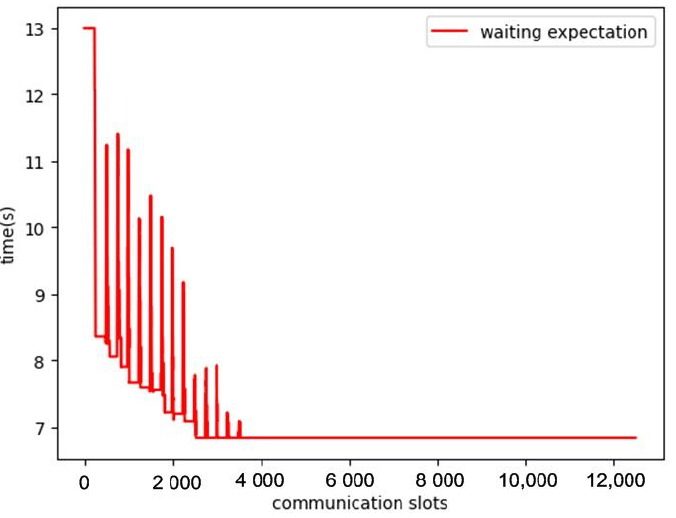
Figure 10. The average expected wait over time, i.e., the average value of expected wait of all nodes in the sensor network in each